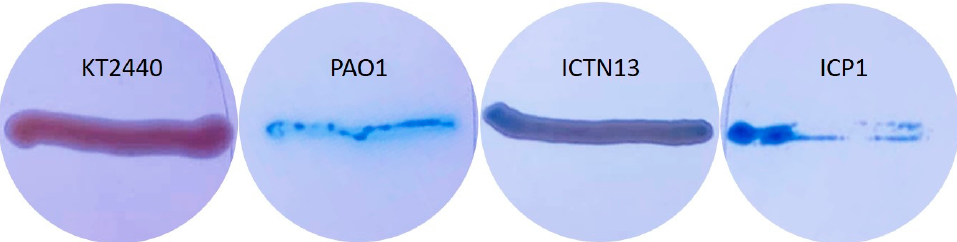
Figure 10. Pseudomonas putida KT2440 (negative control), Pseudomonas aeruginosa PAO1 (positive control), P. oleovorans ICTN13, and A. venetianus ICP1 grown on M9 minimal medium plates containing CTAB, methylene blue, and hexadecane (vapors).